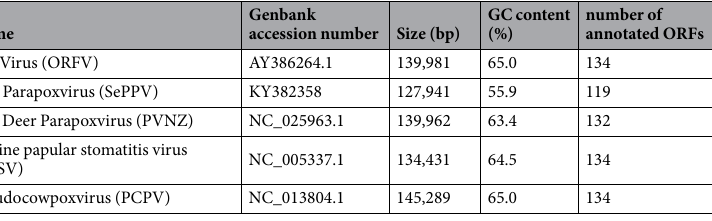
Table 1. Summary of size, relative GC content and number of open reading frames in all full-length genomes of the genus